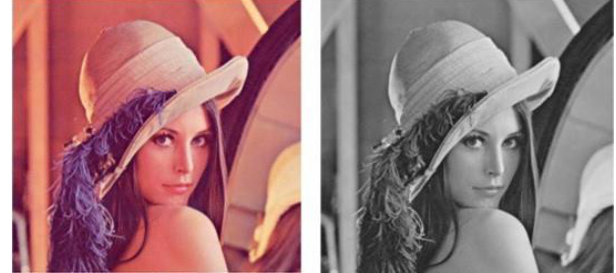
Figure 5. Converting RGB image to grayscale